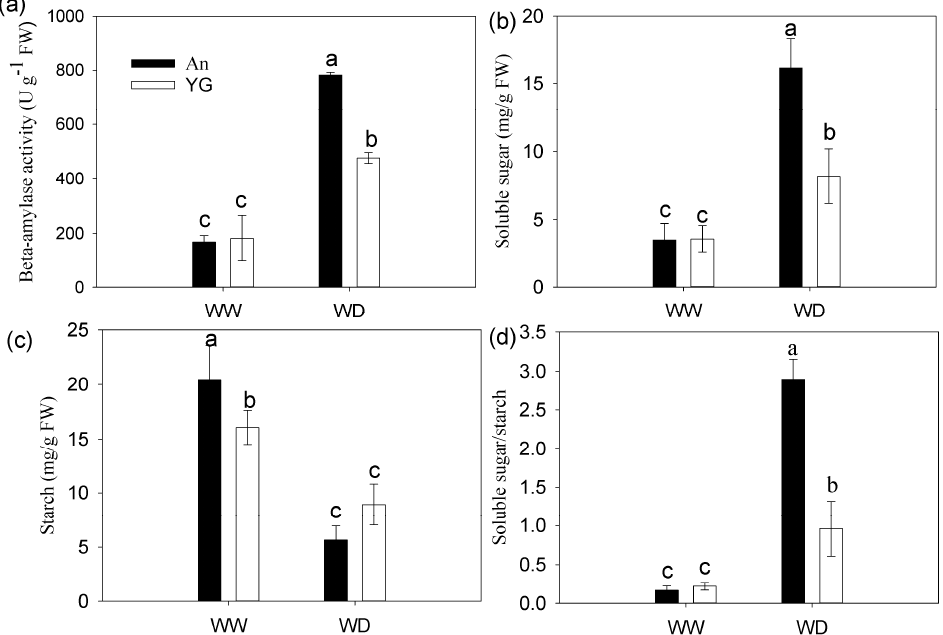
Figure A2. Changes of non-structural carbon (NSC) in the root: ( a ) beta-amylase activity; ( b ) soluble sugar; ( c ) starch; ( d ) soluble sugar to starch ratio. The different letters represent significant differences of WD, WW, An and YG ( p < 0.05).